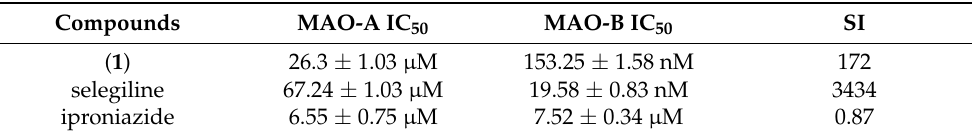
Table 6. MAO-A and MAO-B inhibitory activity results. Compounds MAO-A IC